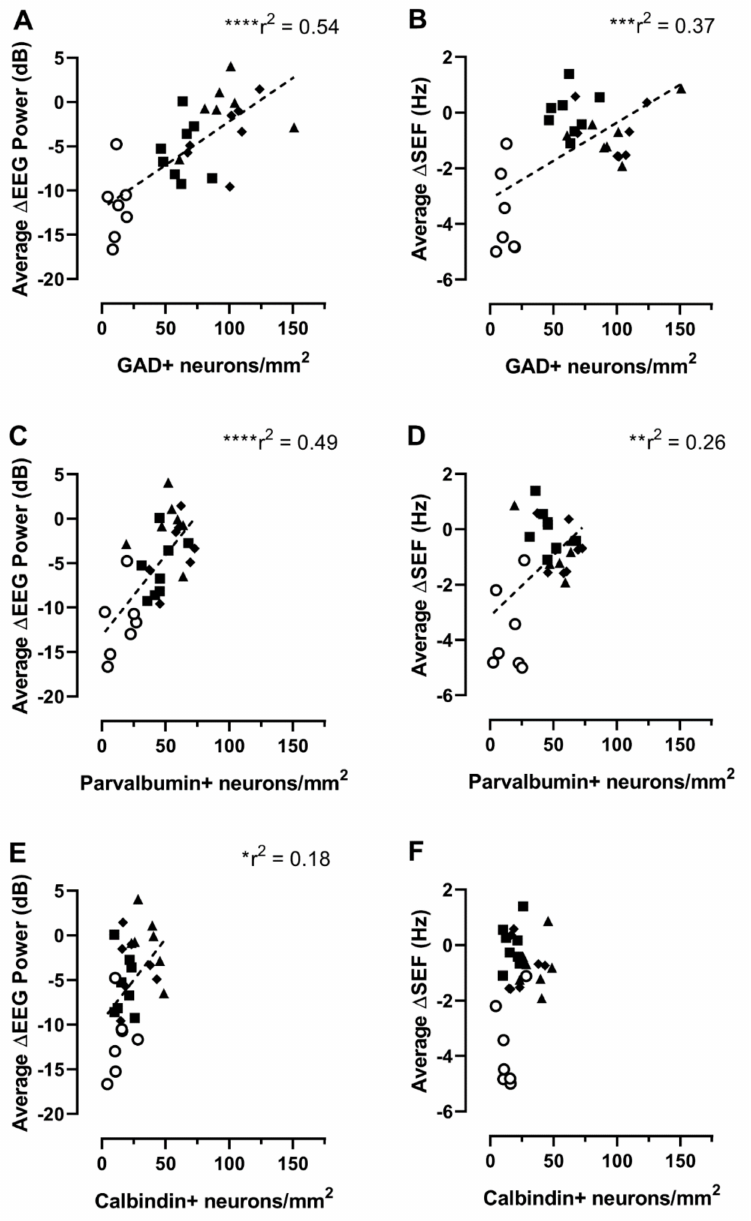
Figure 4. Relationship between cortical interneuron densities and mean electroencephalographic (EEG) power ( A , C , E ) or spectral edge frequency (SEF) ( B , D , F ) measured over the last 24 h of recovery. Note that both EEG and SEF were normalized to the baseline period and are presented as ∆ EEG and ∆ SEF. Ischemia + normothermia group (GAD + , n = 7; parvalbumin + , n = 7; and calbindin + , n = 7; open circles). Ischemia + hypothermia 48 h group (glutamate decarboxylase [GAD] + , n = 8; parvalbumin +